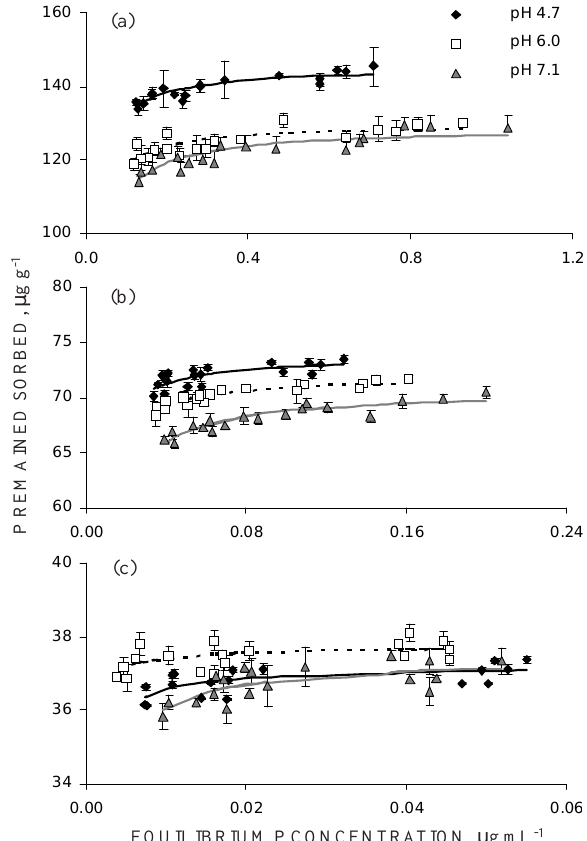
Figure 3. Phosphorus desorption isotherms at three different soil pH levels with three different initial P addition levels. (a) 180 µg g -1 of P. (b) 80 µg g -1 of P. (c) 40 µg g -1 of P. Table 3. Total amount of P sorbed and desorbed and the percent of sorbed P that was desorbed at three different soil pH levels with three different initial P-addition